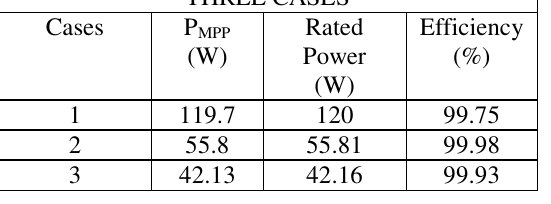
TABLE 3.PERFORMANCE ANALYSIS OF OPTIMIZED FPAALGORITHM